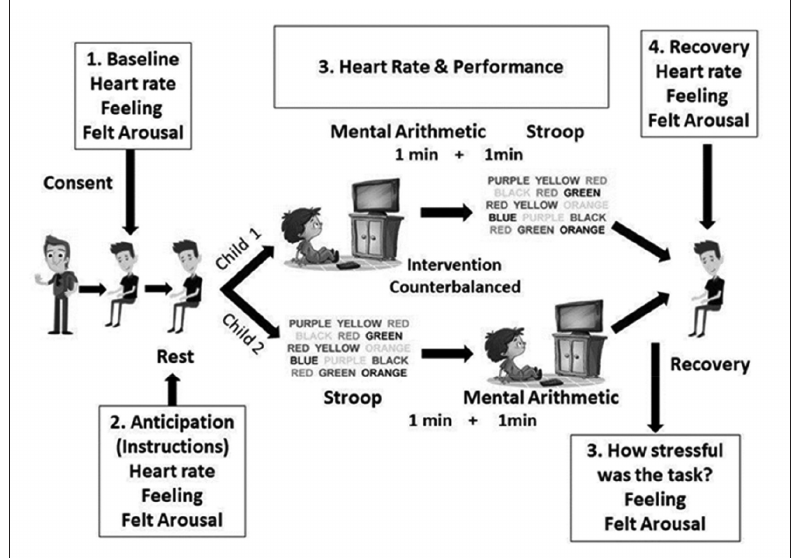
Figure 1. Illustration of the experimental